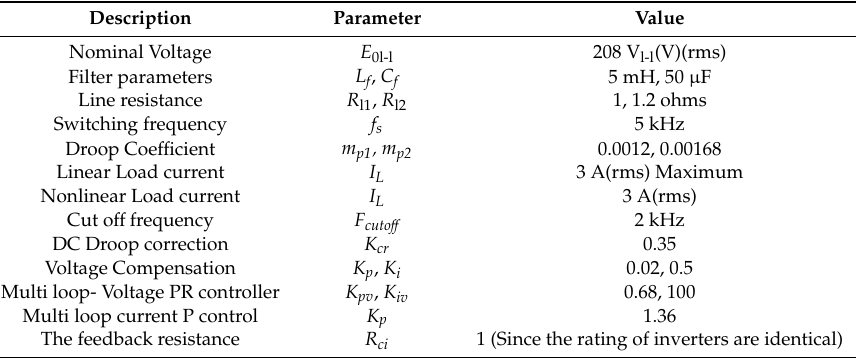
Table 1. System and control parameters.